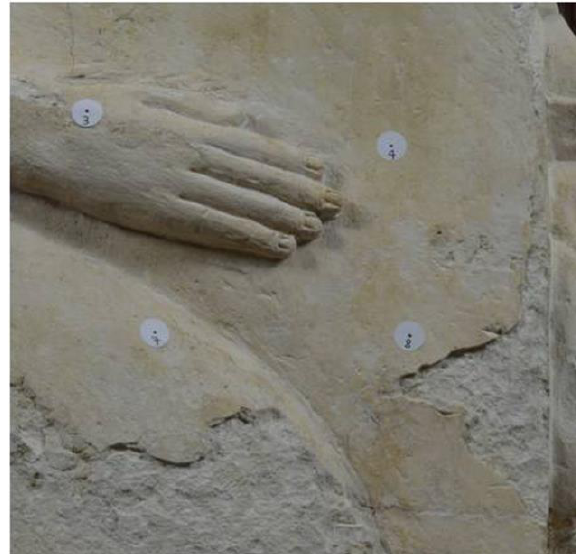
Figure 8. Some circular sticky stamps used to materialize TX and RX points.